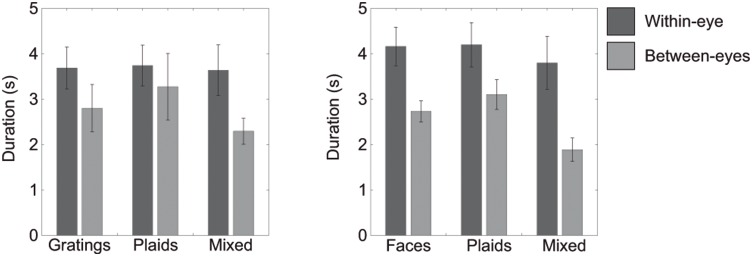
Median percept durations for Experiment 2.Within-eye dominance durations are presented in dark grey. Between-eye dominance durations are presented in light grey. Error bars represent the 95% confidence intervals. For graphical purposes the data was normalized by each participant’s overall median duration before being averaged across subjects and then multiplied by the overall median across all participants. Note the strong dependency on the eye-of-origin of the dominant images.